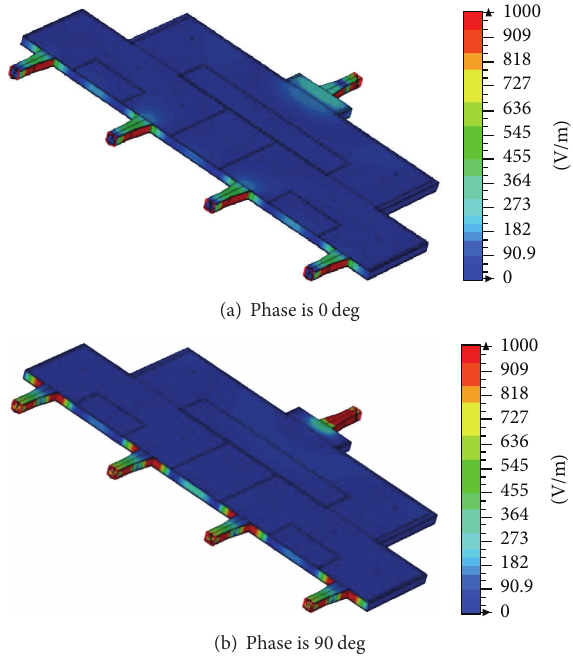
Figure 7: Electric field of the 4-way SIW power divider.